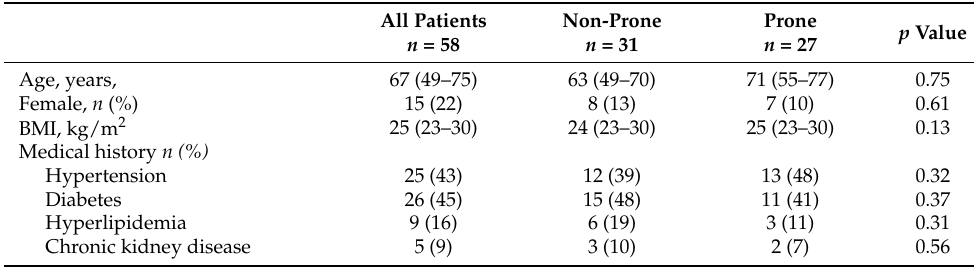
Table 1. Baseline patient characteristics between the two groups based on prone therapy.